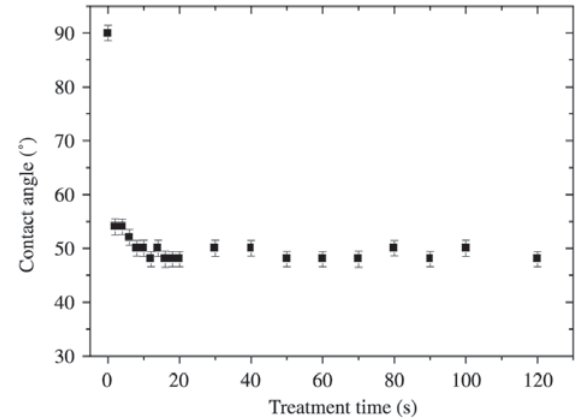
Figure 4. Contact angle (using water) as a function of corona treat- ment time of PP